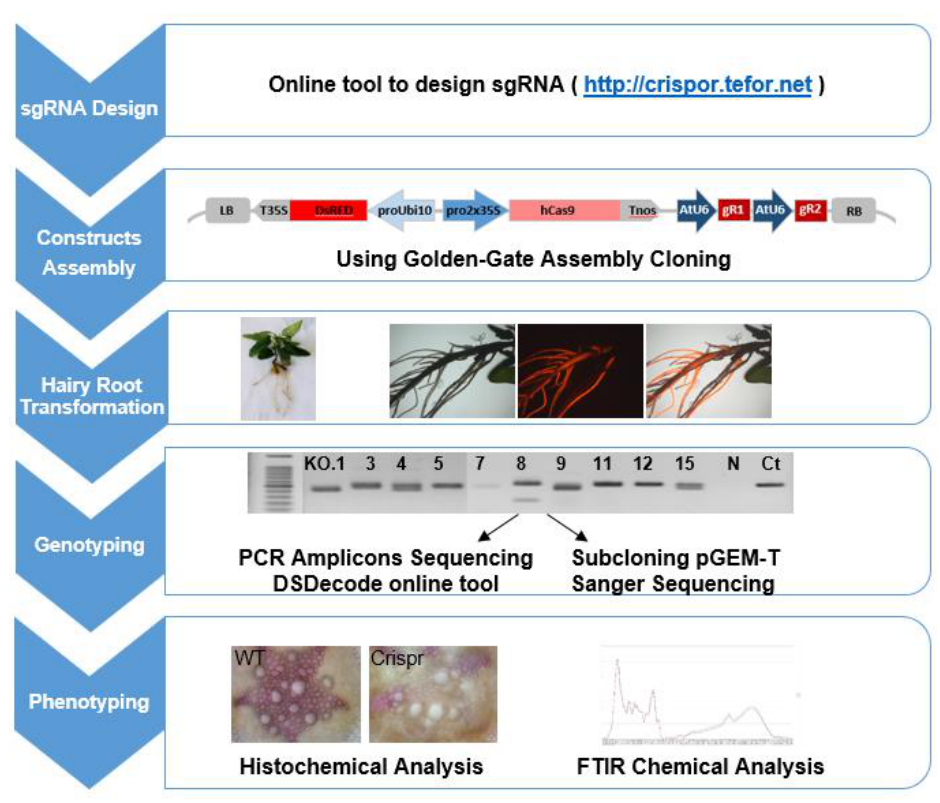
Figure 4. Pipeline of CRISPR / Cas9 implementation in Eucalyptus grandis hairy roots.